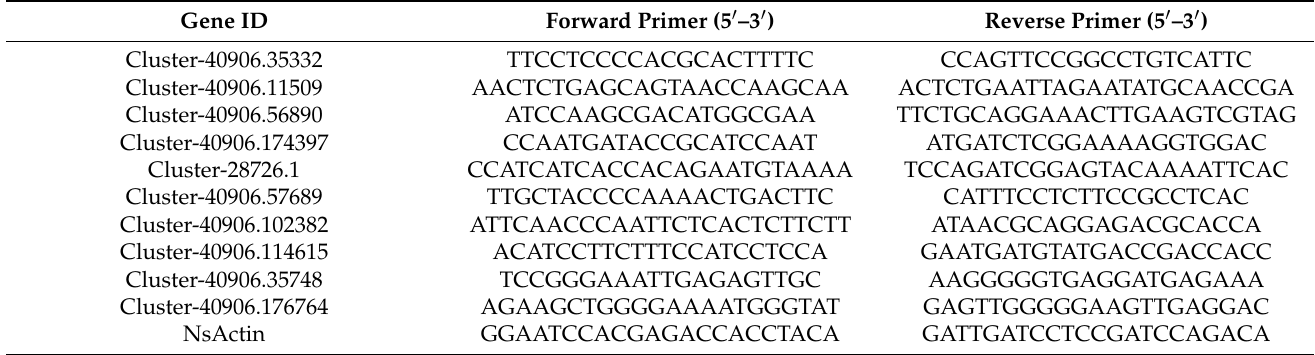
Table 1. Information about of ten